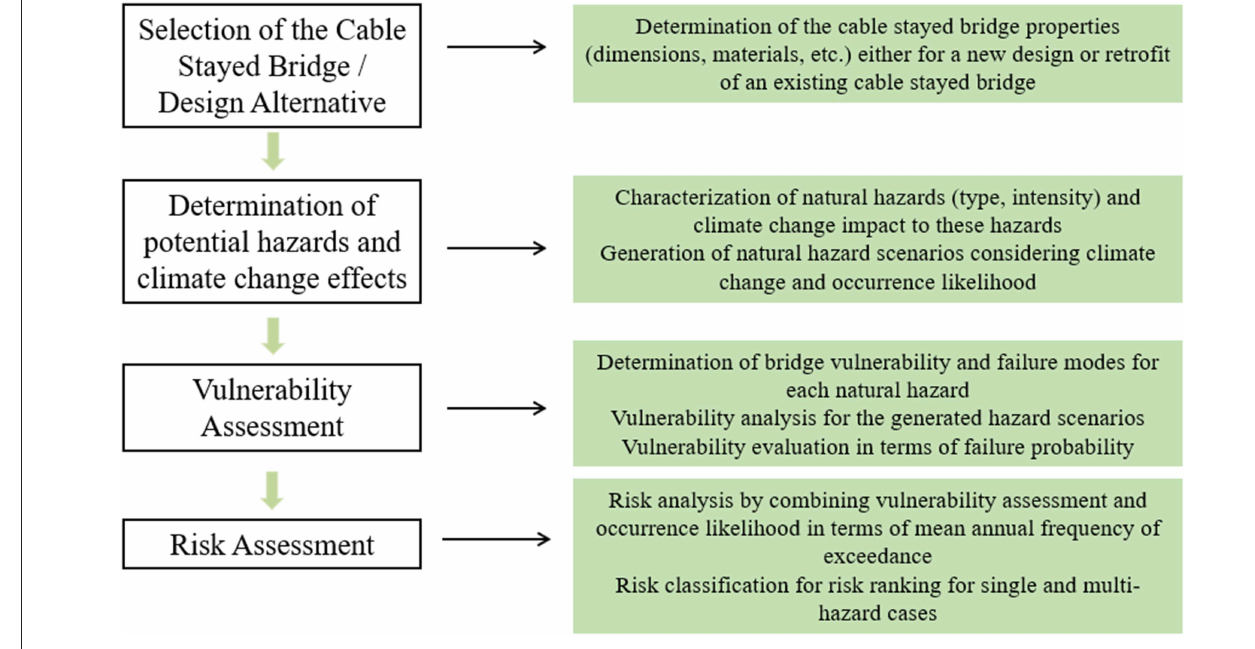
FIGURE 1 | Adaptation methodology for cable-stayed bridges.